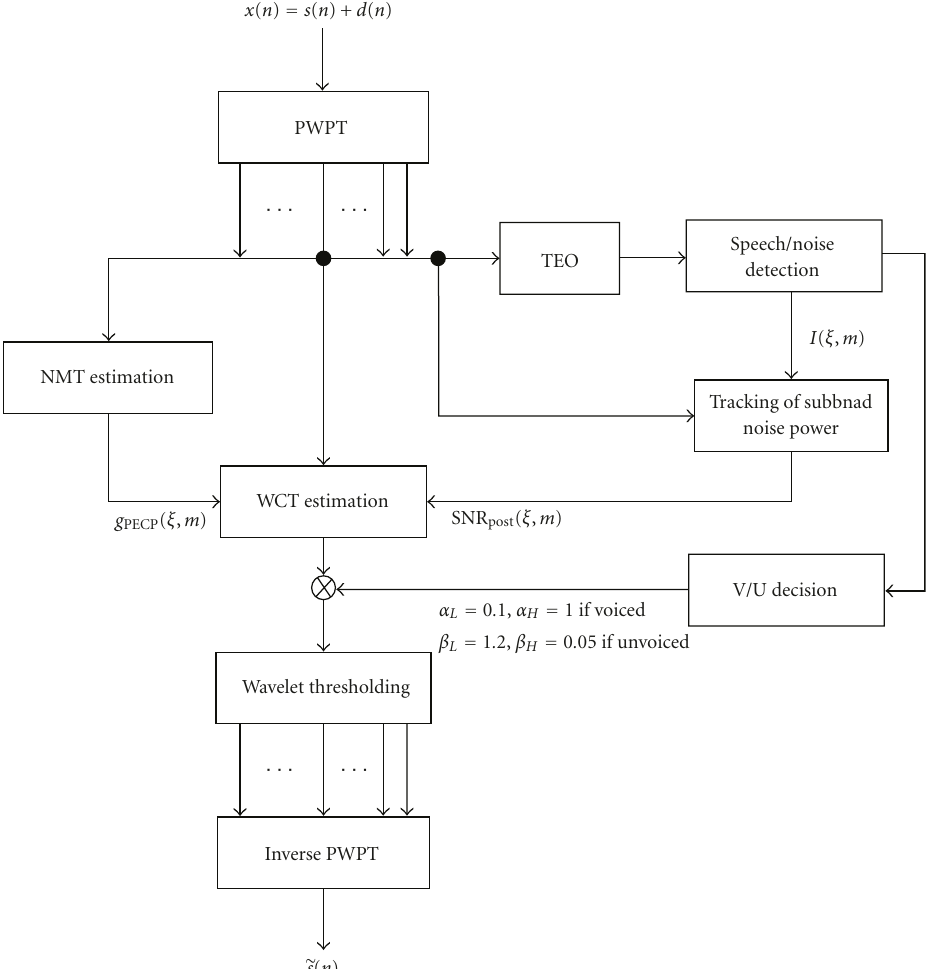
Figure 1: The architecture of proposed speech enhancement method based on the time-frequency adaptation of the wavelet threshold.